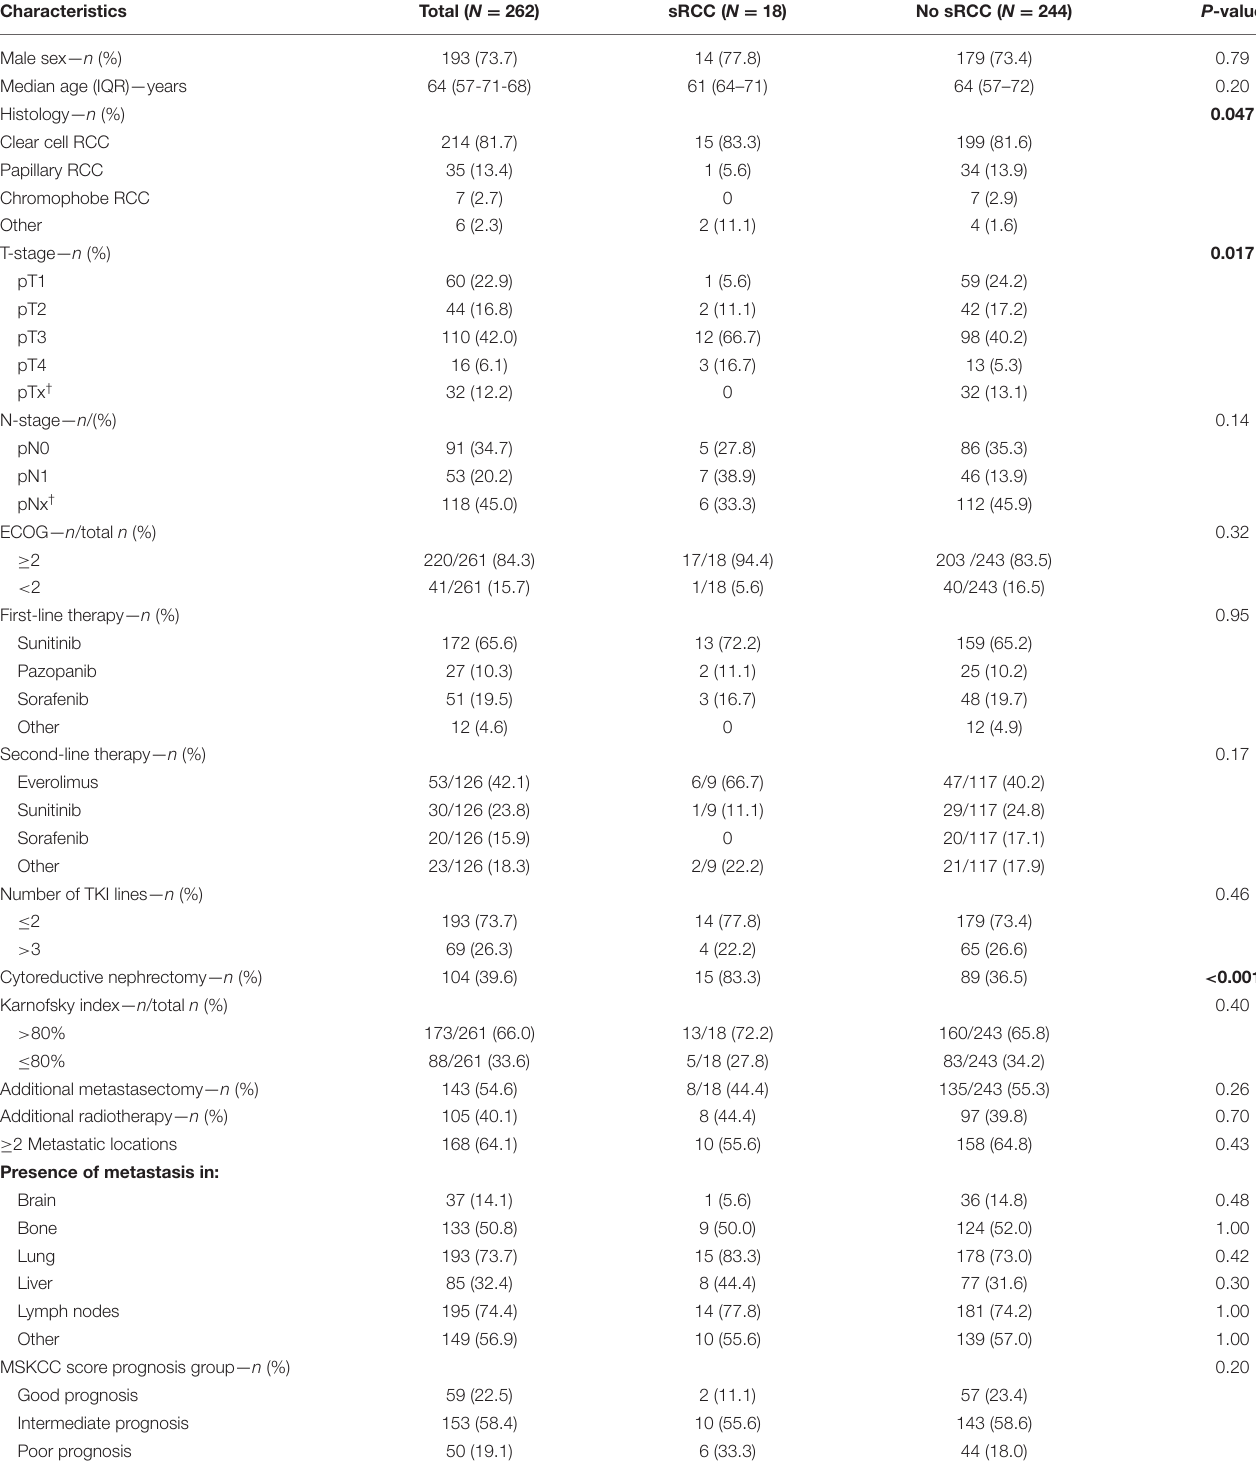
TABLE 1 | Demographic and clinical characteristics of